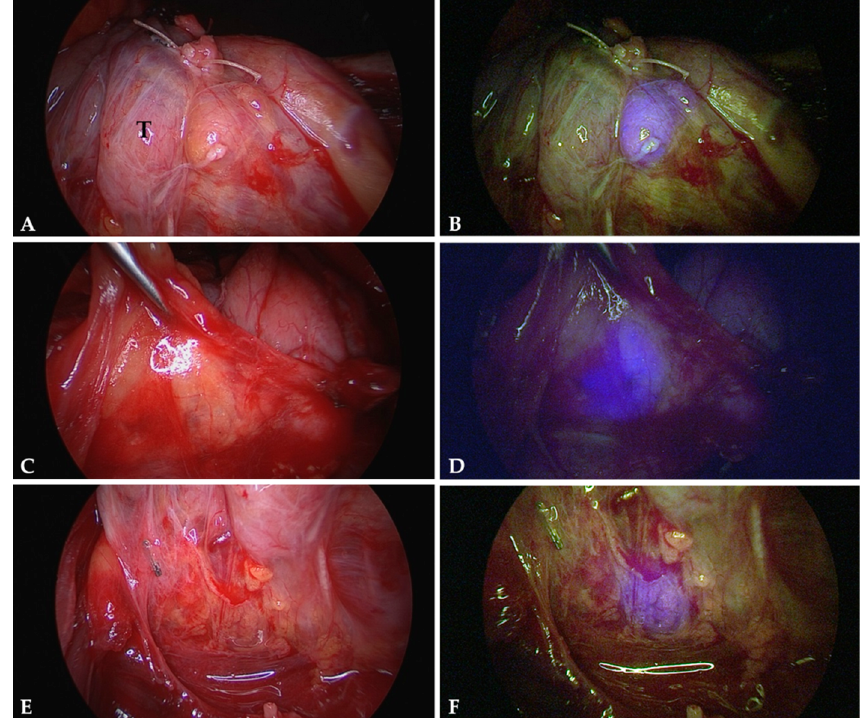
Figure 1. Autofluorescence of normal parathyroid glands. The images correspond to parathyroid glands exposed to normal white light ( A , C , E ) and near-infrared light ( B , D , F ). Parathyroid tissue displays a well recognizable bluish violet colour representing autofluorescence. The surrounding structures remain nonfluorescent. Note the different appearances of parathyroid tissue: a parathyroid gland stuck to the thyroid surface (T) ( A , B ); a parathyroid gland distant to the thyroid and covered by adipose tissue ( C , D ); and parathyroid tissue well hidden in between lymphatic and adipose tissue ( E , F ).